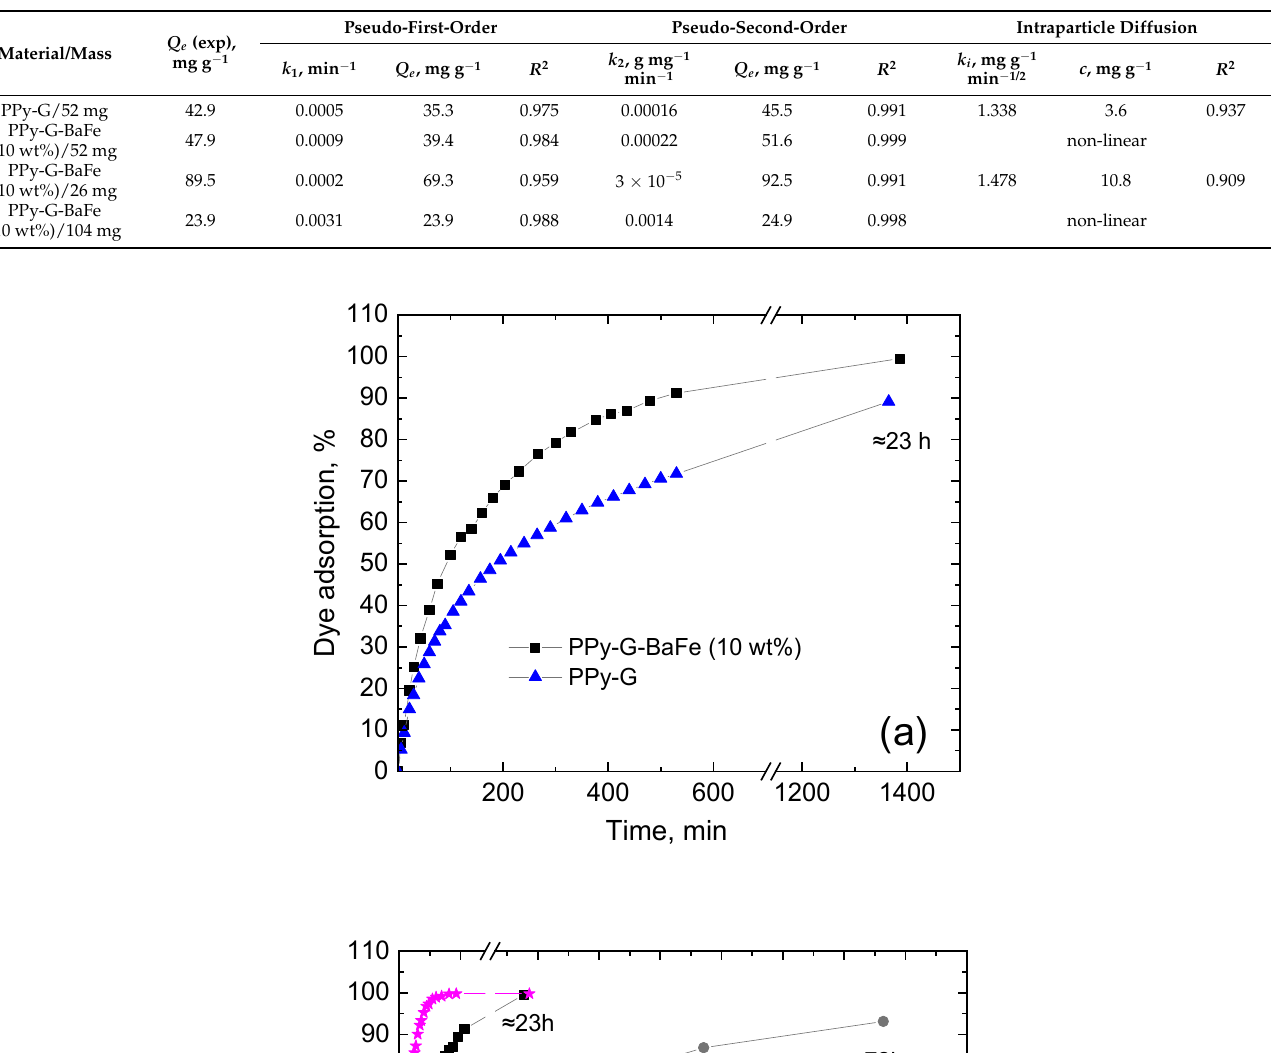
Table 3. Fitted kinetics parameters and experimental Q e of Reactive Black 5 adsorption kinetics with PPy-G-BaFe (10 wt%) and PPy-G as adsorbents.